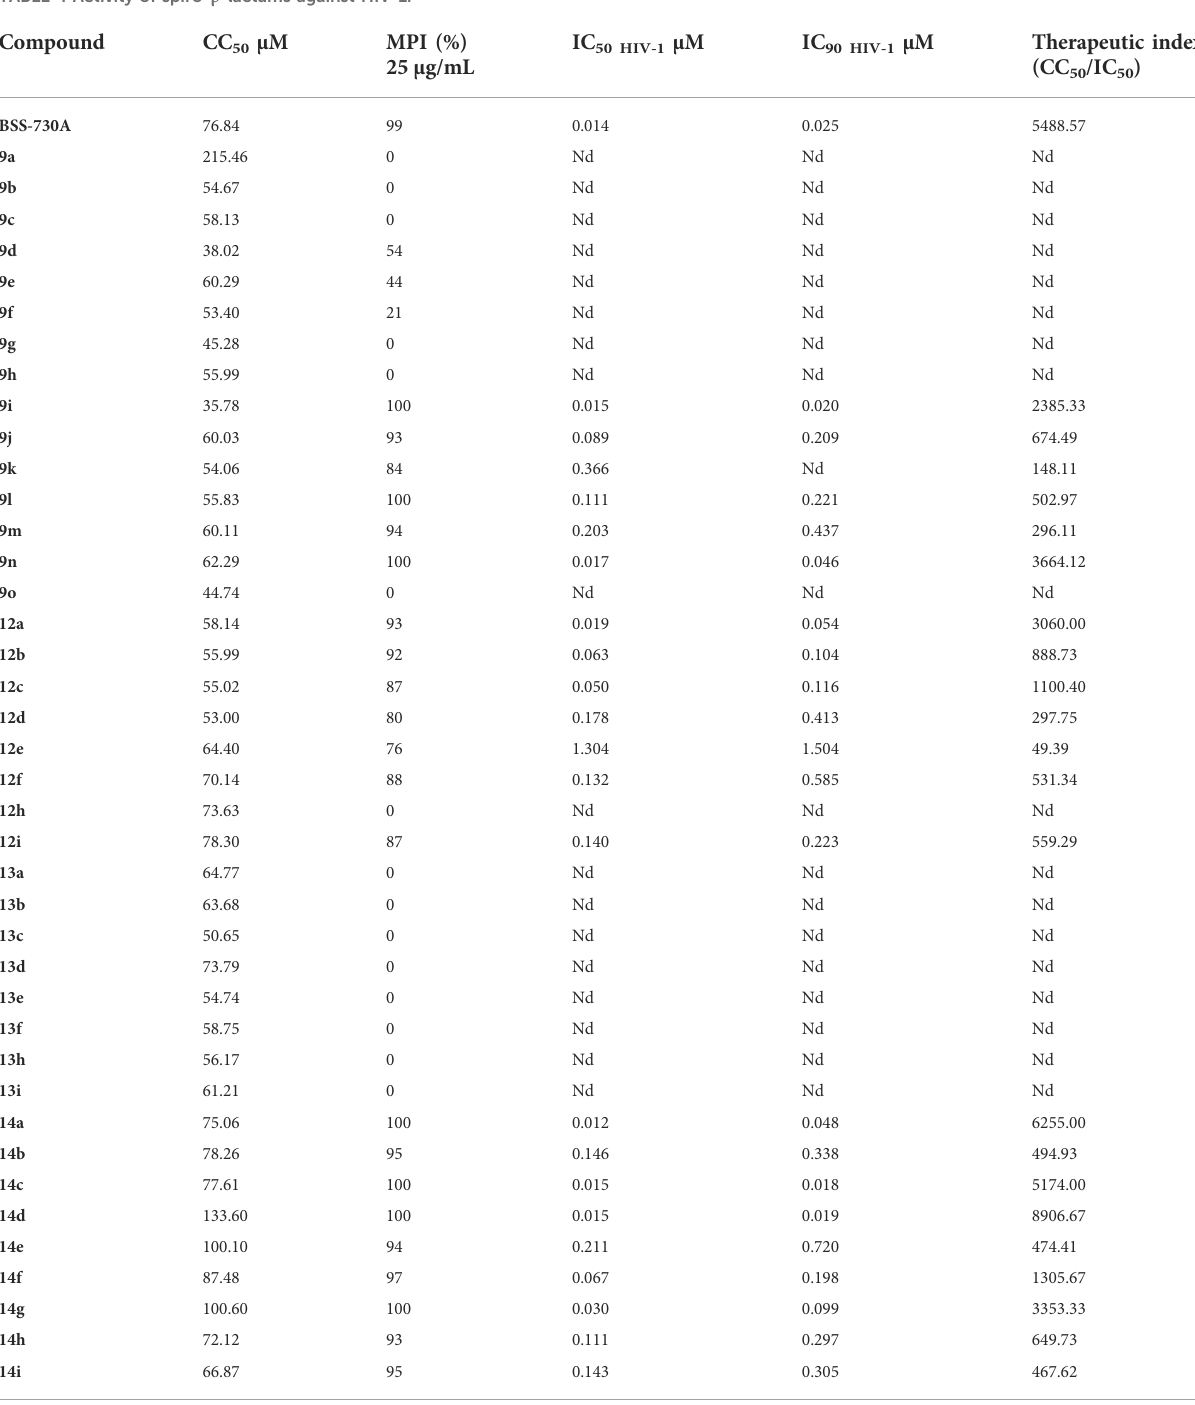
TABLE 4 Activity of spiro- β -lactams against